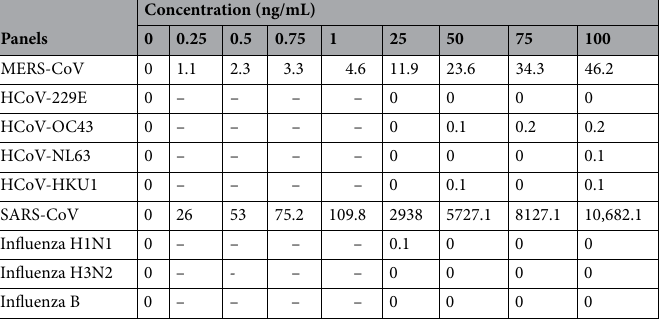
Table 3. Cut-off index (COI) values in negative controls. HCoV human coronavirus, MERS-CoV Middle East respiratory syndrome-related coronavirus, SARS-CoV severe acute respiratory syndrome coronavirus, SARS- CoV-2 severe acute respiratory syndrome coronavirus 2.